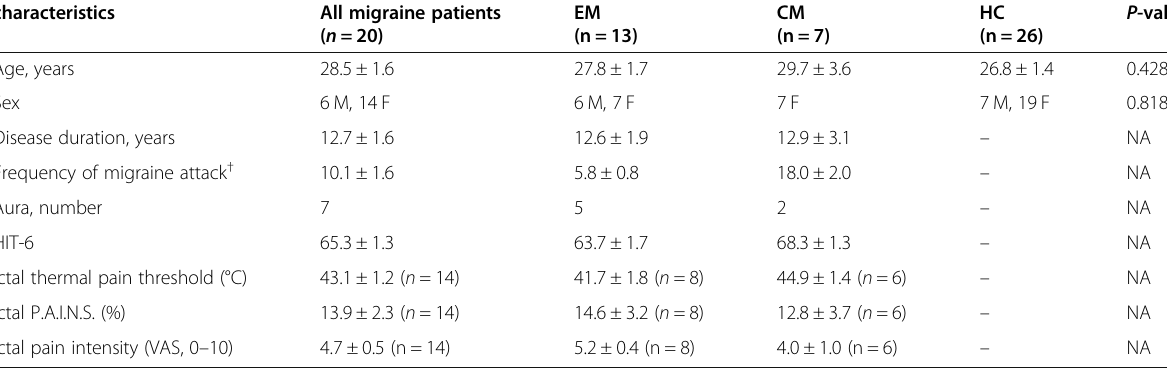
Table 1 Demographic and clinical characteristics of study participants